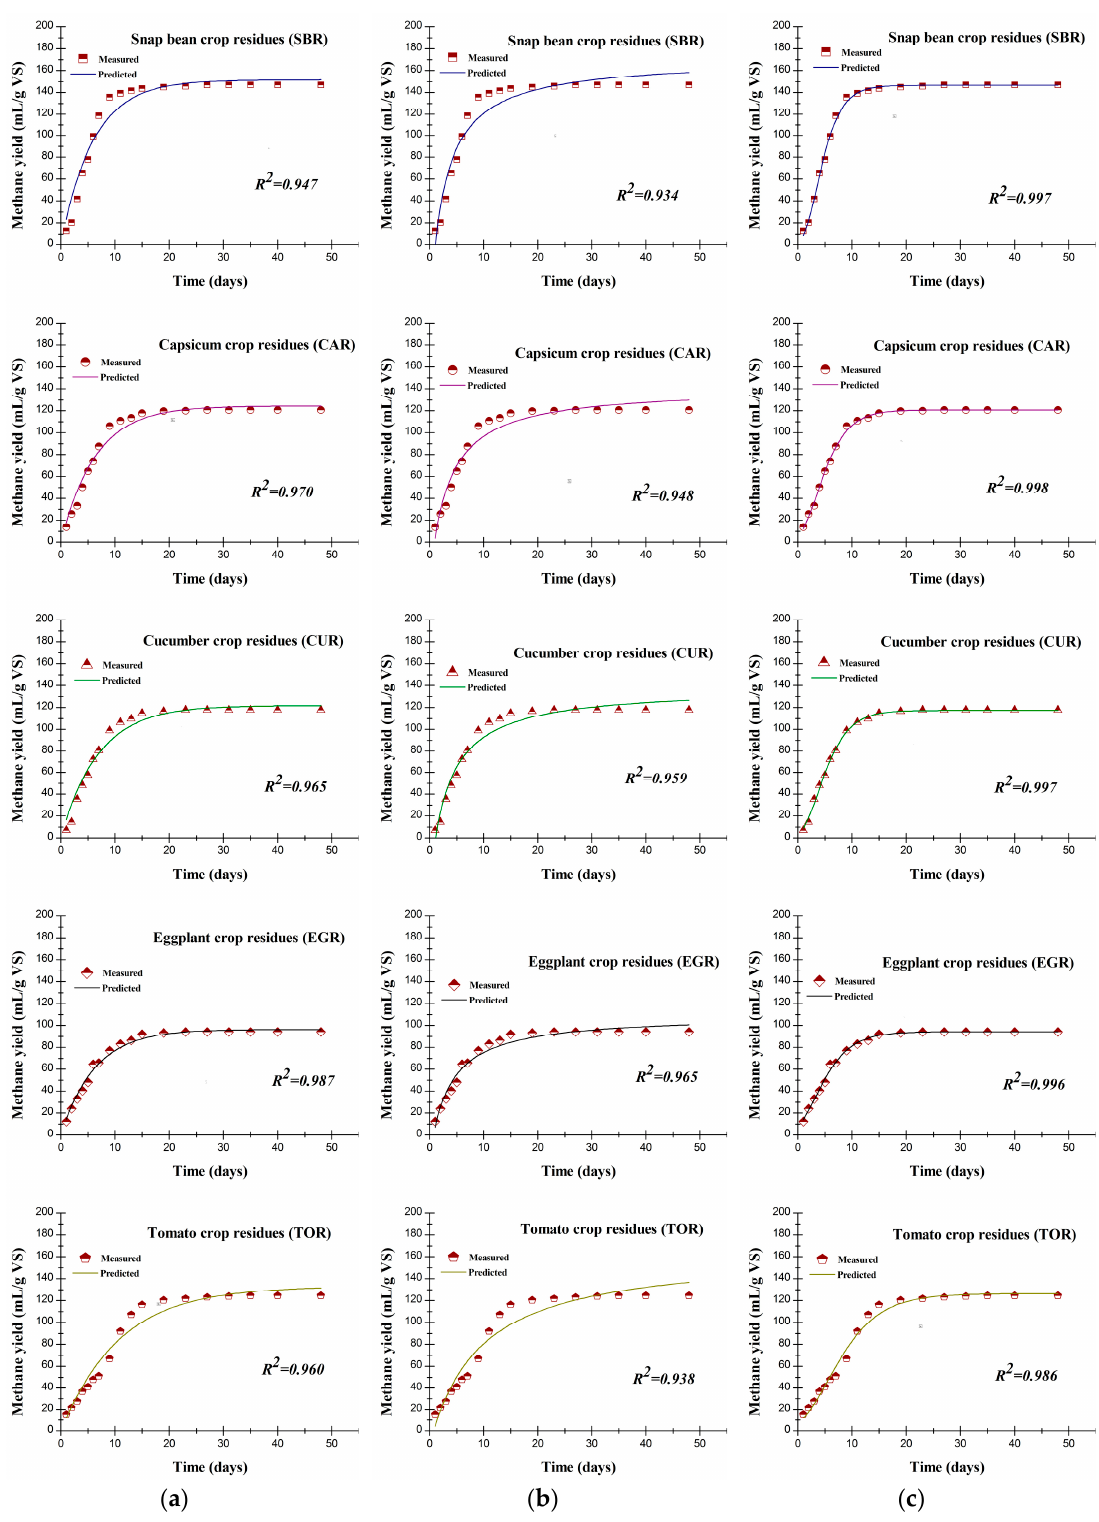
Figure 3. VCR methane yield plotted with methane predicted using ( a ) first-order kinetic model; ( b ) Chen and Hashimoto model, and ( c ) modified Gompertz model; R 2 represents determination coefficient.